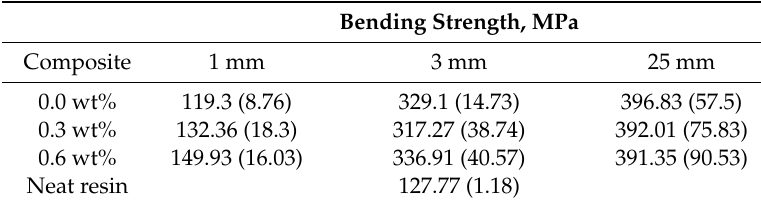
Table 2. The flexural strengths of composites and neat resin.